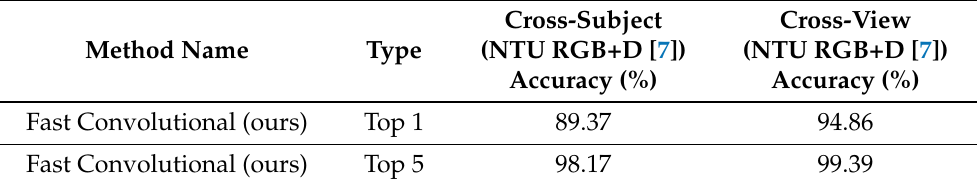
Table 5. Performances obtained by the convolutional model for the NTU RGB+D dataset [7] from the perspective of Top 1 and Top 5 accuracy.